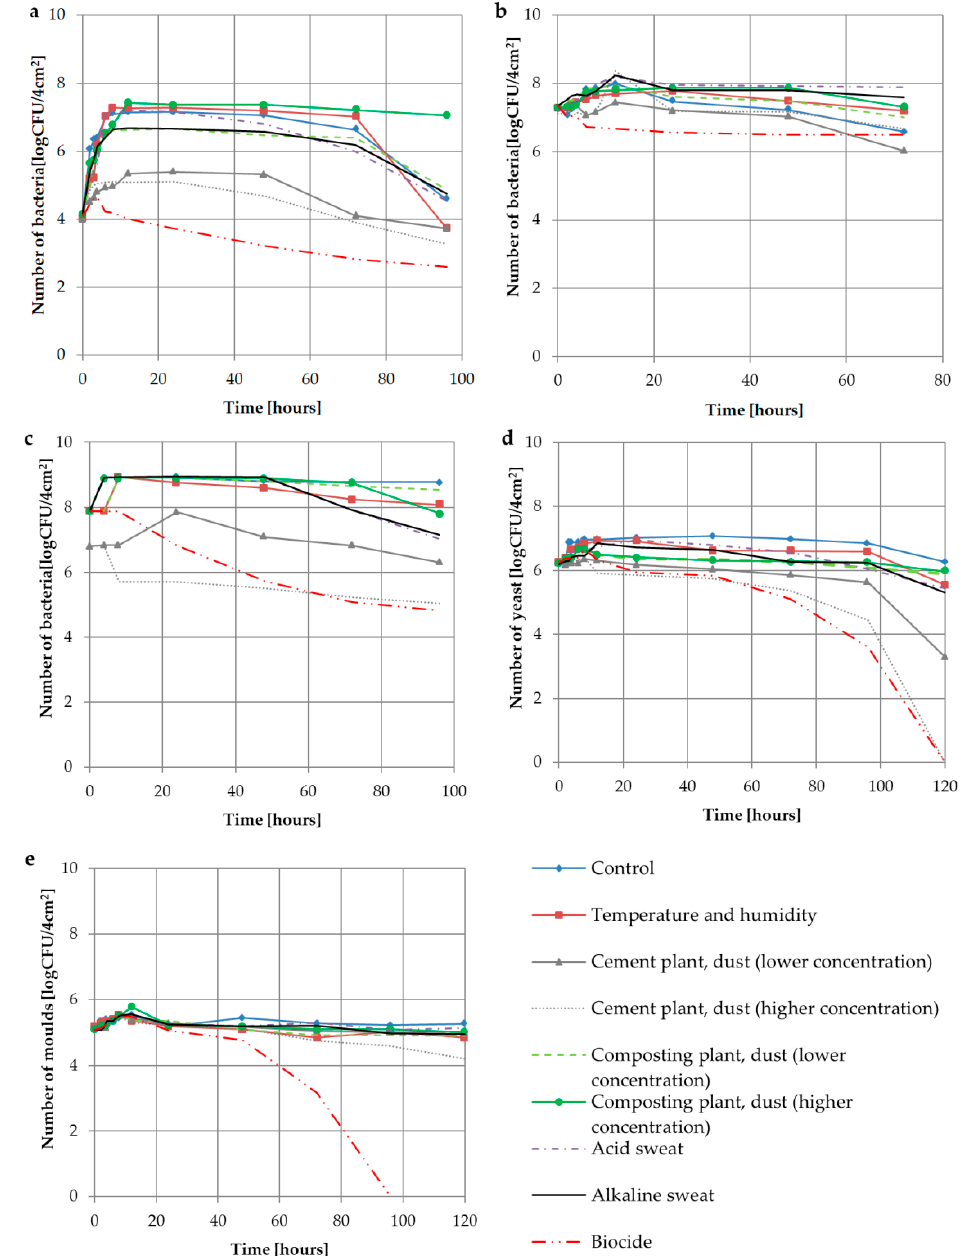
Figure 2. The dynamics of microbial survival on the filtering nonwoven during the incubation depending on the factors studied: ( a ) B. subtilis ; ( b ) S. aureus ; ( c ) E. col ; ( d ) C. albicans ; ( e ) A. niger .